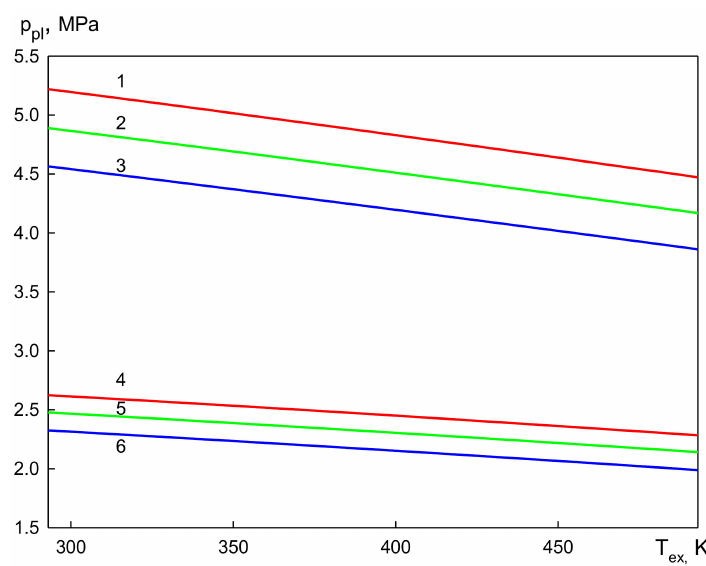
Figure 6. Dependence of the plastic resistance limit on the temperature of the outer wall: R in = 0.1 m, R ex = 0.105 m. Curves 1–3: Λ p = 100 nm, δ = 10 nm; curves 4–6: Λ p = 200 nm, δ = 20 nm; curves 1 and 4–temperature of the inner wall of the pipe T in = 293 K; curves 2 and 5– T in = 393 K and curves 3 and 6– T in = 493 K.